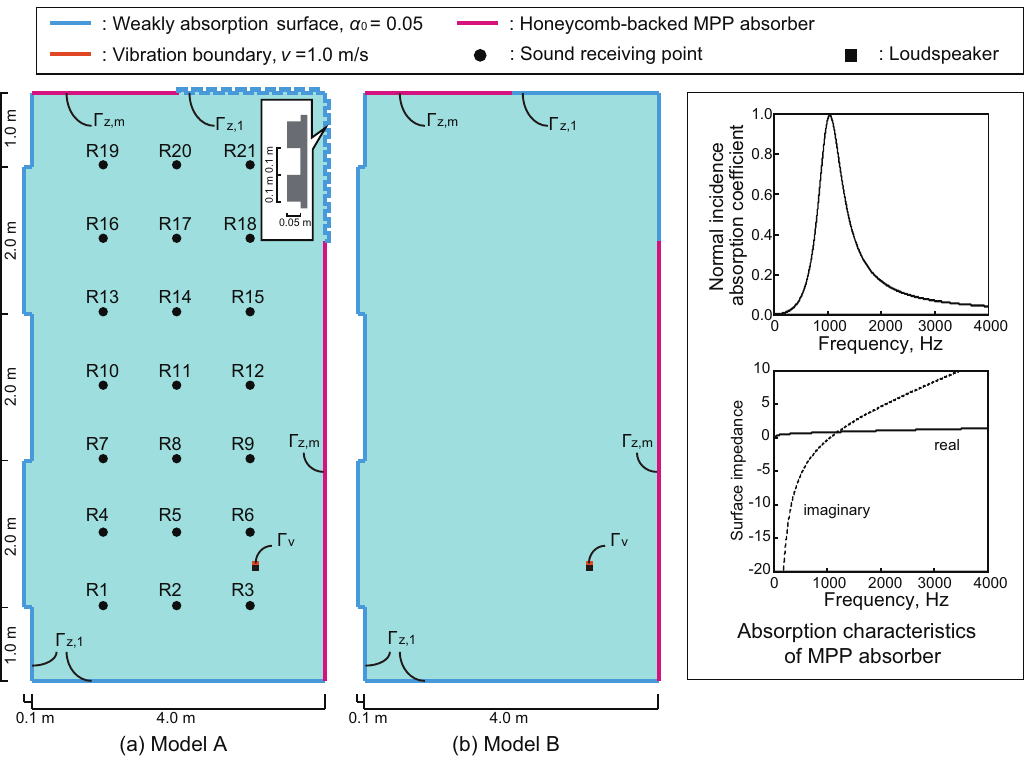
Figure 2. Two office room models with 21 sound-receiving points: ( a ) office room with the rib-type acoustic diffuser (Model A) and ( b ) more simply shaped office room without the acoustic diffuser (Model B). The room model includes three BCs: weakly absorbing surface Γ z,1 , frequency-dependent absorbing surface Γ z,m assuming a honeycomb-backed MPP sound absorber, and vibration boundary Γ v assuming a loudspeaker. The absorption characteristics of the MPP absorber are also shown. These problems have no analytical solutions. Therefore, we calculated reference solutions with a fourth-order-accurate FEM [8,52] using sufficiently fine meshes. Three meshes were created according to the analyzed frequencies where 0.01 m square elements were used for frequencies of 20 Hz to 1.5 kHz, 0.005 m square elements were used for frequencies of 1.5 kHz to 3 kHz, and 0.0025 m square elements were used for frequencies of 3 kHz to 4 kHz. These meshes have spatial resolutions of 22, 22, and 34 elements per wavelength, respectively, at 1.5 kHz, 3 kHz, and 4 kHz. Table 1 presents